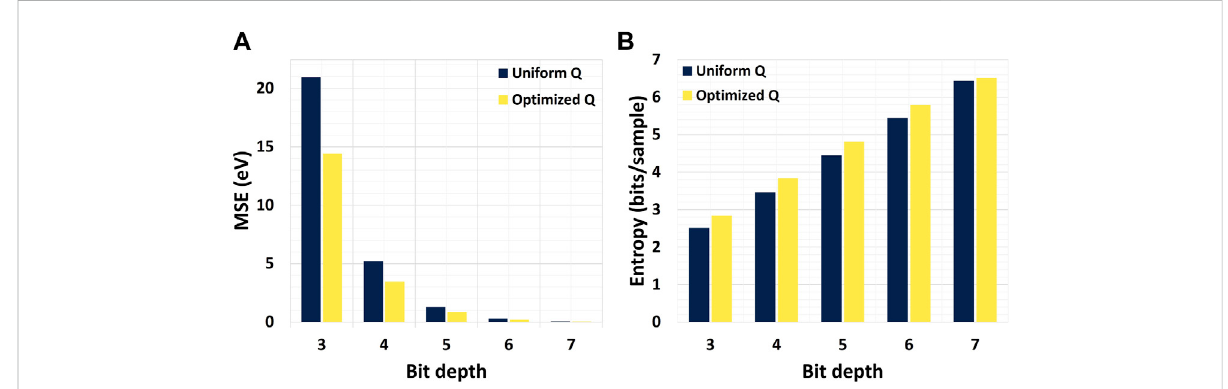
FIGURE 3 Mean-square error (A) and entropy (B) as a function of the quantization. We interpret low mean-square error with high entropy as a better information representation within data.